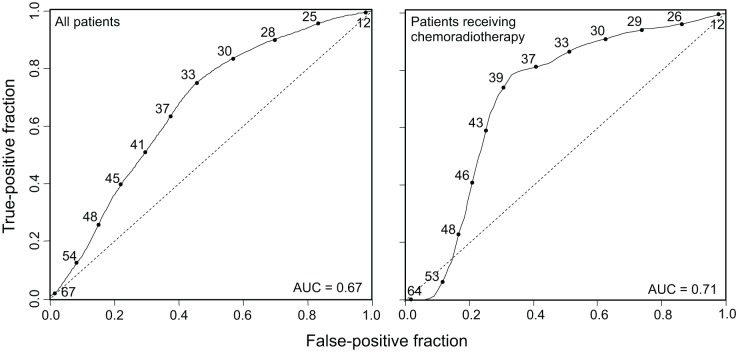
MATH receiver operating characteristic curves.Time-dependent ROC curves (solid lines) evaluated at 3-y survival, obtained by the nearest neighbor method of Heagerty et al. [44], with a smoothing span of 0.1. Curves show the relation between sensitivity (true-positive fraction) and specificity (1 − false-positive fraction) as the MATH value used to distinguish high- from low-heterogeneity tumors (values shown along the curves) is altered. Dashed lines are lines of identity. Left, ROC curve for all 305 patients (95% CI for AUC, 0.60 to 0.74). Right, ROC curve for 78 patients receiving chemoradiation as primary therapy or as an adjuvant to surgery (95% CI for AUC, 0.54 to 0.82).